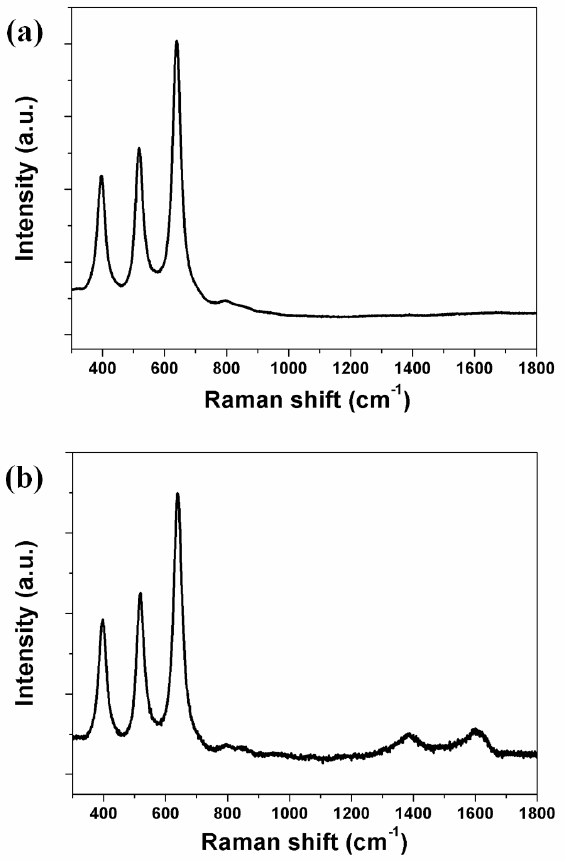
Figure 3. Raman spectra of ( a ) freestanding TiO 2 nanotube arrays alone and ( b ) freestanding TiO 2 nanotube arrays with carbon materials.